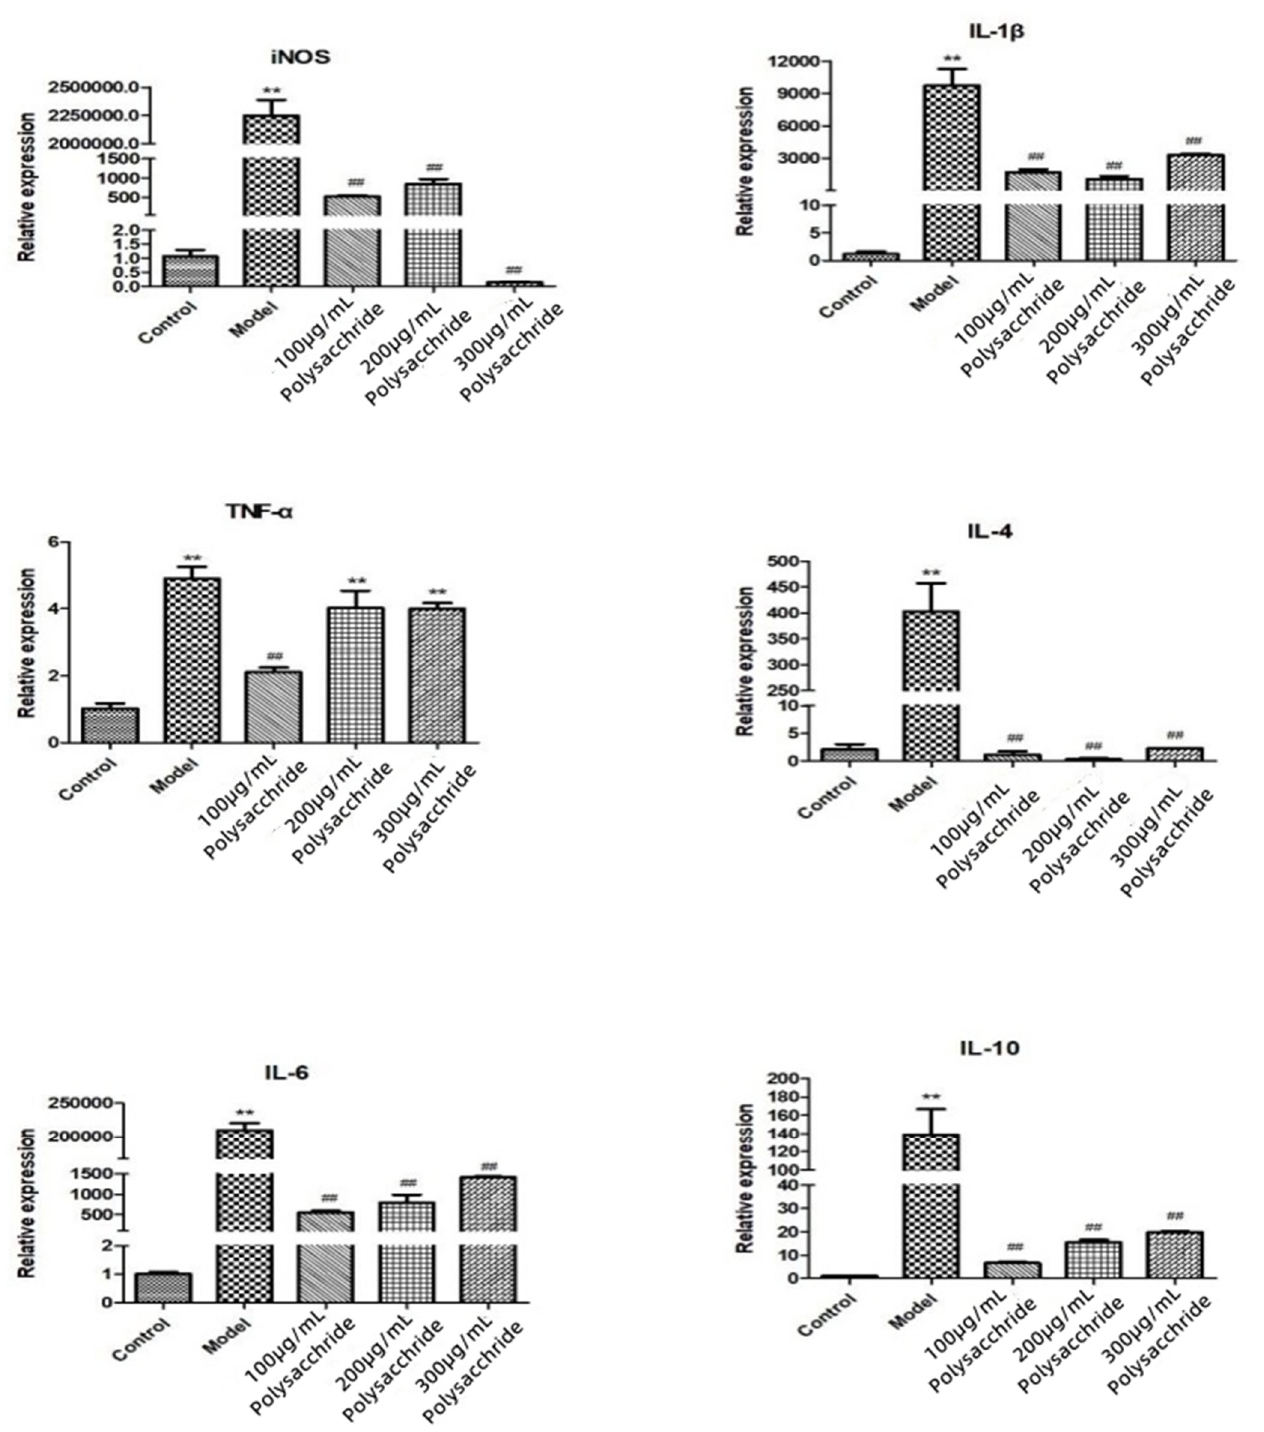
Figure 9. Effects of LJP on mRNA expression levels of inflammatory factors in LPS-induced RAW264.7 macrophages. (## p < 0.05; ** p < 0.01)